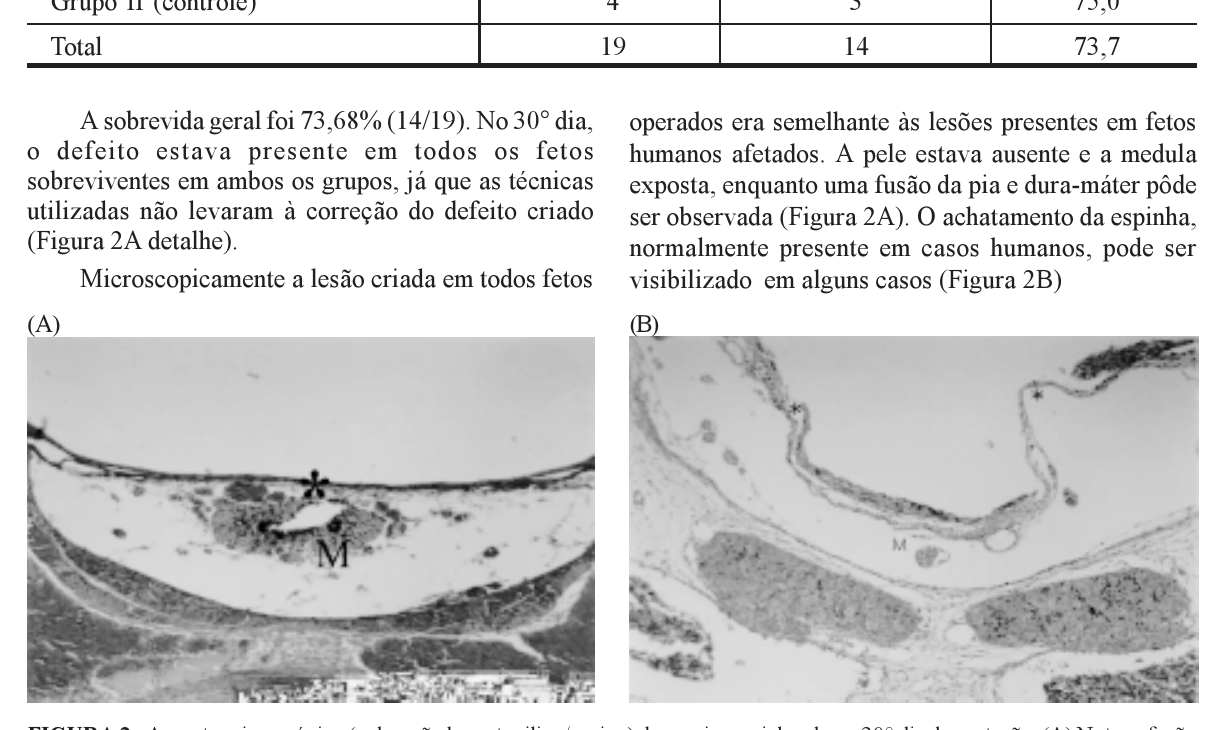
FIGURA 2 - Aspecto microsc(cid:243)pico (colora(cid:231)ªo hematoxilina/eosina) da meningomielocele no 30(cid:176) dia de gesta(cid:231)ªo. (A) Notar a fusªo da pia e dura-mÆter (*) e o achatamento da medula (M) presentes em alguns casos (B). No detalhe, o aspecto macrosc(cid:243)pico da lesªo pode ser